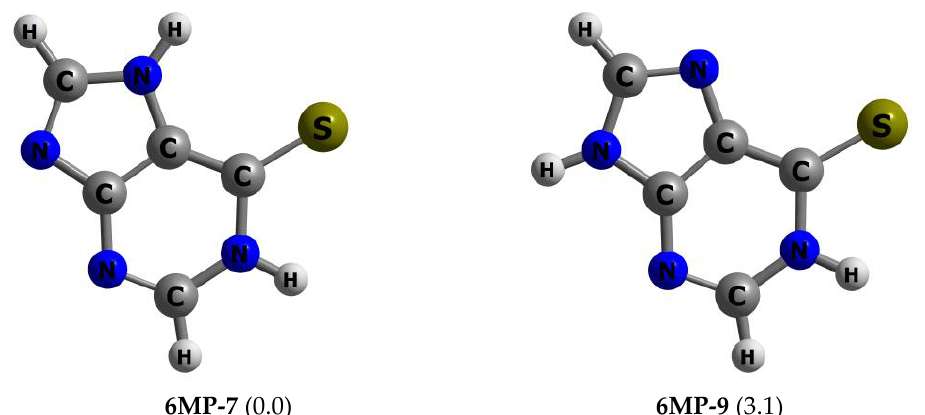
6MP-7 (0.0) Figure 2. Equilibrium structures of two MP lowest-energy tautomers. Values given in parentheses are their relative energies in the gas phase (kcal/mol at the PBE/cc-pVTZ level).